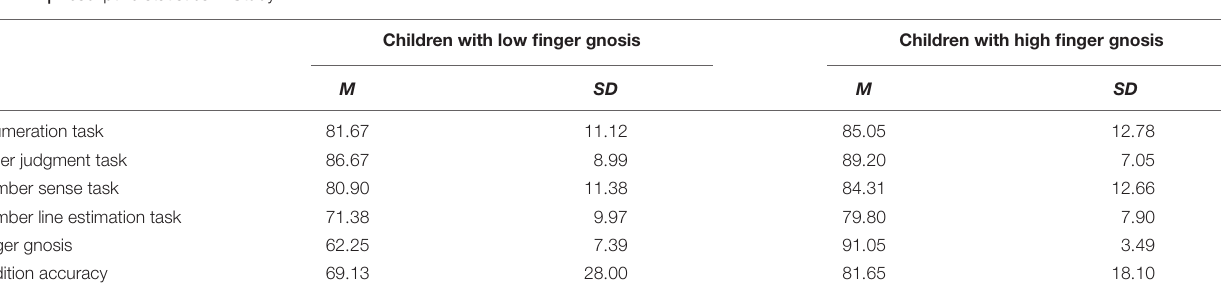
TABLE 4 | Descriptive statistics in Study